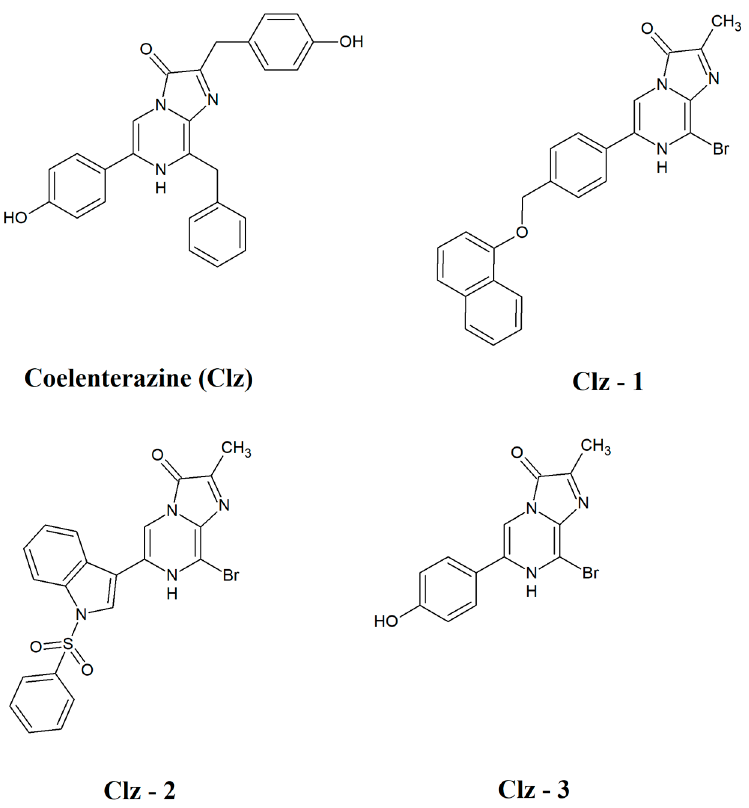
Figure 1. Chemical structures of natural Coelenterazine (Clz) and the three Coelenterazine derivatives here synthesized.